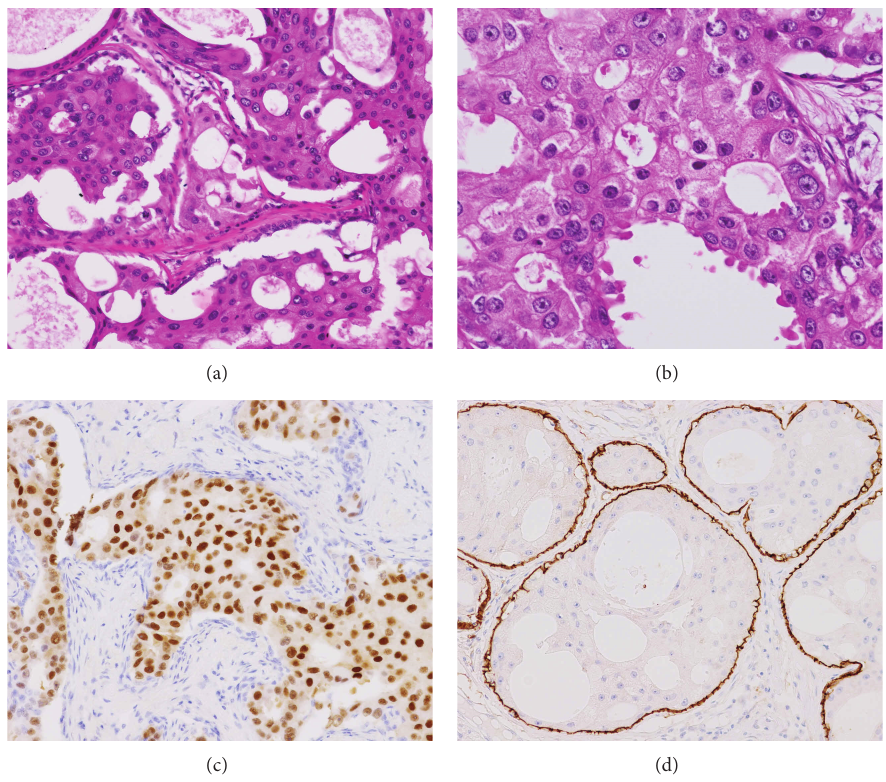
Figure2:Histologicalfeaturesofapocrinecarcinomaintheleftbreast.((a)and(b))HE.Thetumorcellshadabundanteosinophiliccytoplasm and apocrine snouts. (c) Tumor cells expressed androgen receptors in their nuclei. (d) The intraductal component is represented by a continuous myoepithelial cell layer detected by CD10